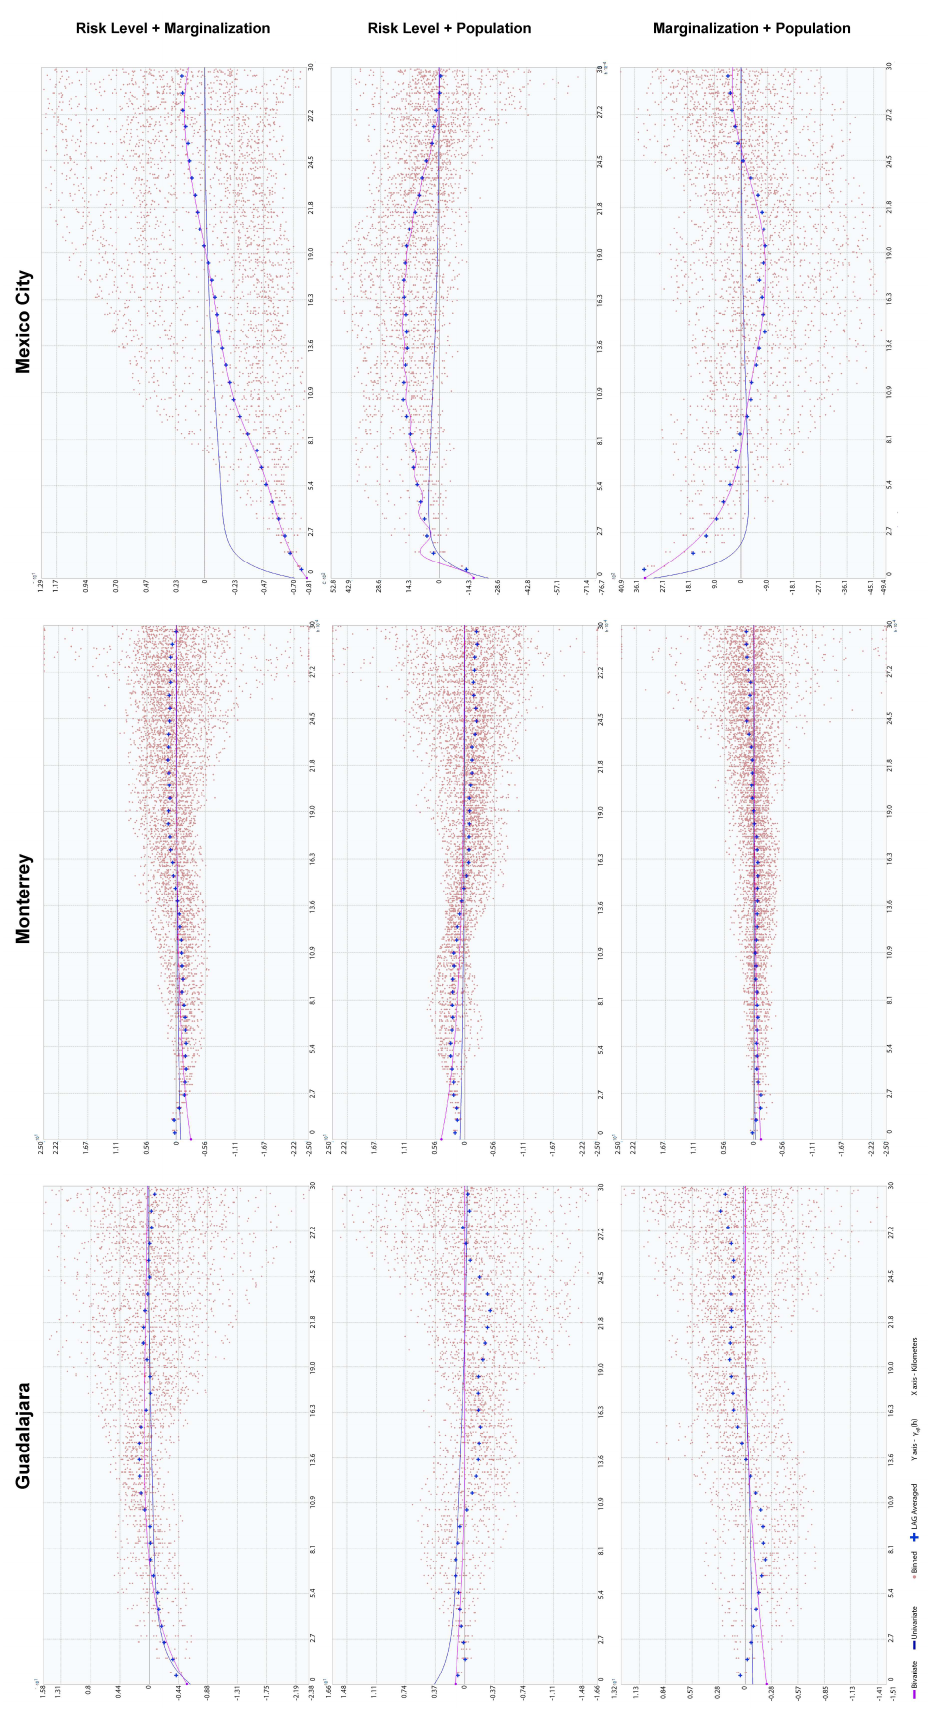
Figure 6. Correlograms of each city and pair of